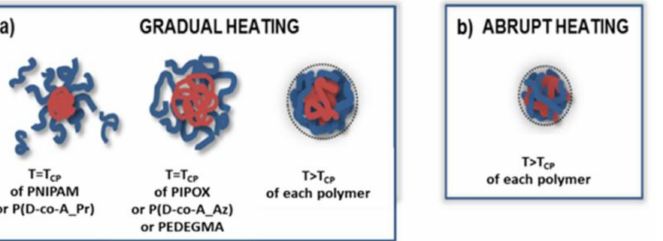
Figure 3. Schematic presentation of the strategy for preparing mesoglobules in mixtures of thermore- sponsive polymers: ( a ) with a core–shell structure and ( b ) homogenously mixed